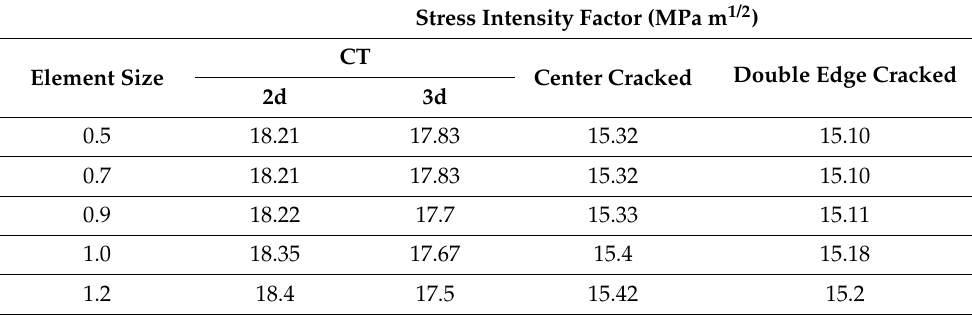
Table 6. Mesh sensitivity analysis of CT, double edge cracked, and center cracked specimen in ST condition.